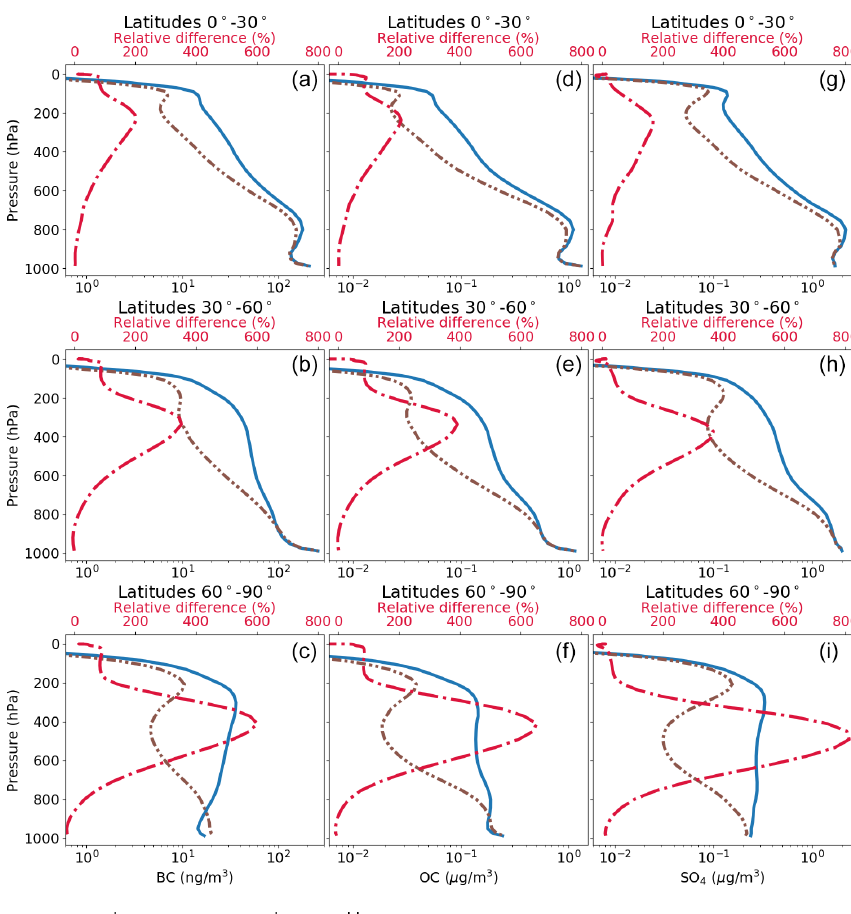
Figure 2. Vertical profiles of BC (a–c) , OC (d–f) , and SO 4 (g–i) , simulated with old and current in-cloud wet deposition schemes at different latitude bands. Note the different units for the different compounds.